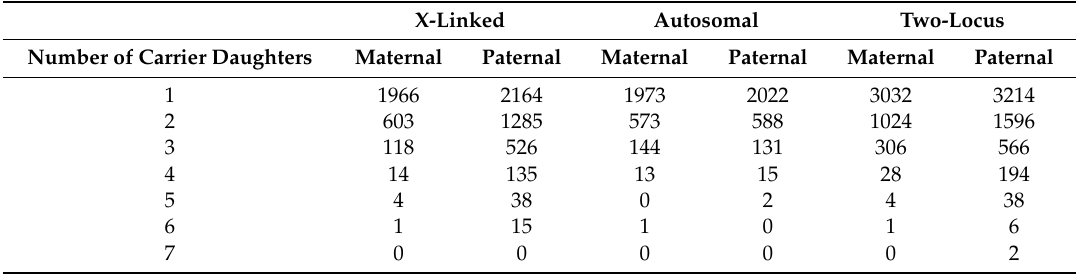
Table 3. Simulated frequencies of maternal and paternal lineages by number of carrier